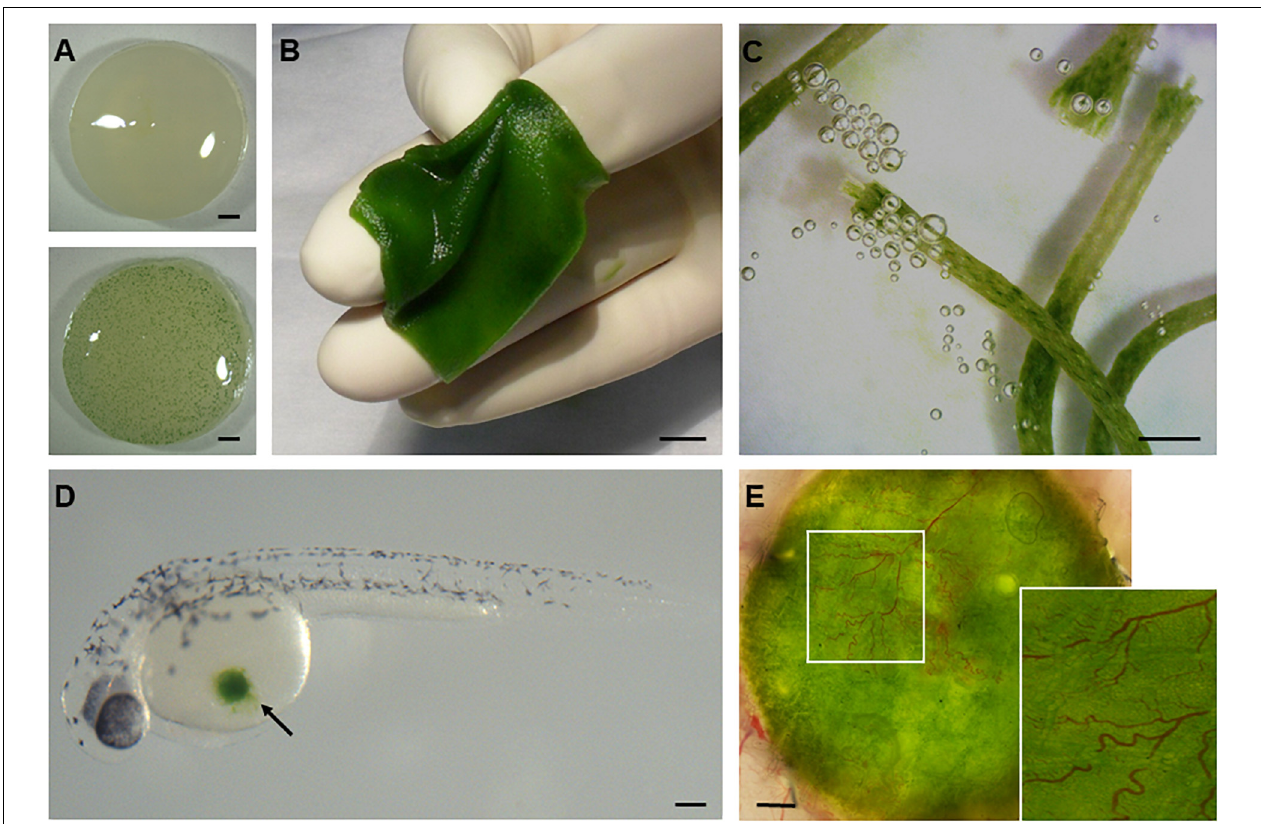
FIGURE 2 | Development of photosynthetic biomaterials. The combination of photosynthetic microorganisms such as cyanobacteria (A) and green algae (B–E) with biomedical devices routinely used in clinical practice, such as dermal scaffolds (B) or suture threads (C) , has enabled the development of biomaterials that are capable of producing oxygen in situ . Moreover, the biocompatibility of these organisms with animal life has been demonstrated both in vitro under co-cultivation conditions with mammalian cells and in vivo in several vertebrate models like zebrafish (D) and mice (E) . Scale bars represent 1 mm in (A,C,E) , 1 cm in (B) , and 0.2 mm in (D)